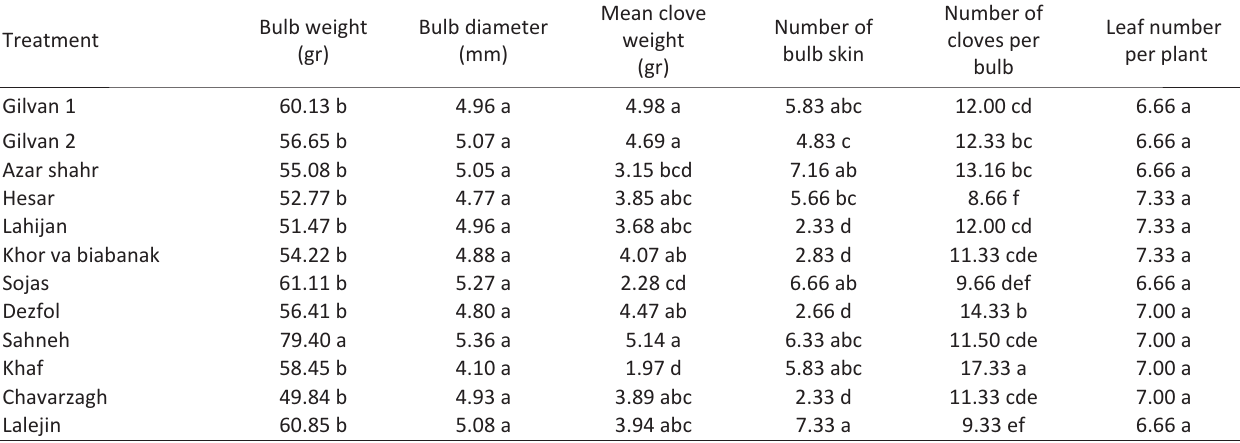
In each column different letters mean significant differences between